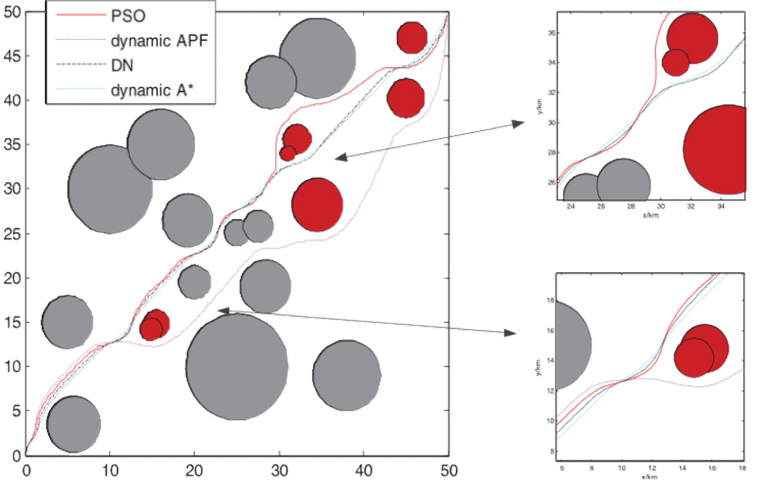
Figure 15. Collision avoidance performance using training data, comparing with Particle Swarm (PSO), the dynamic A * algorithm, and Artificial Potential Field (APF)